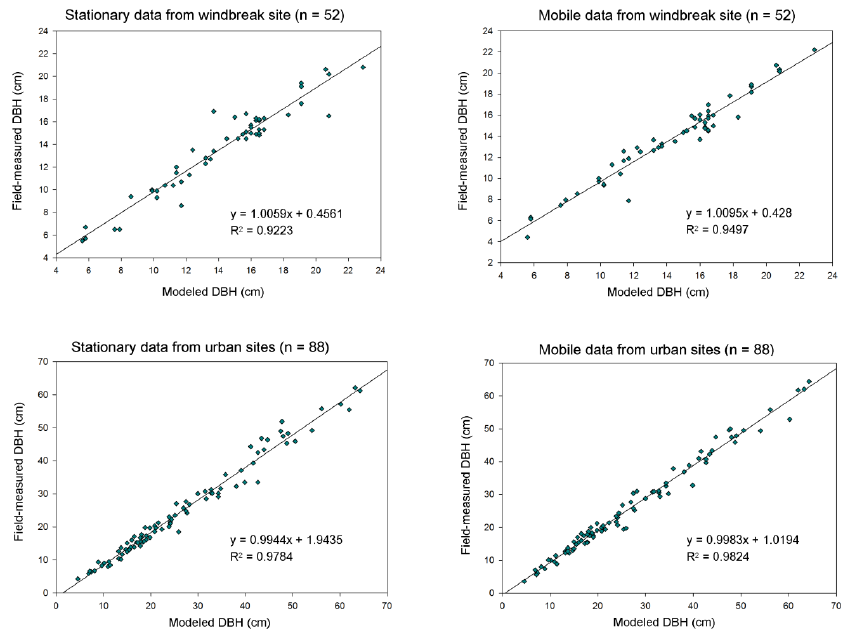
Figure 3. Comparison between stationary and mobile data based on site classification.